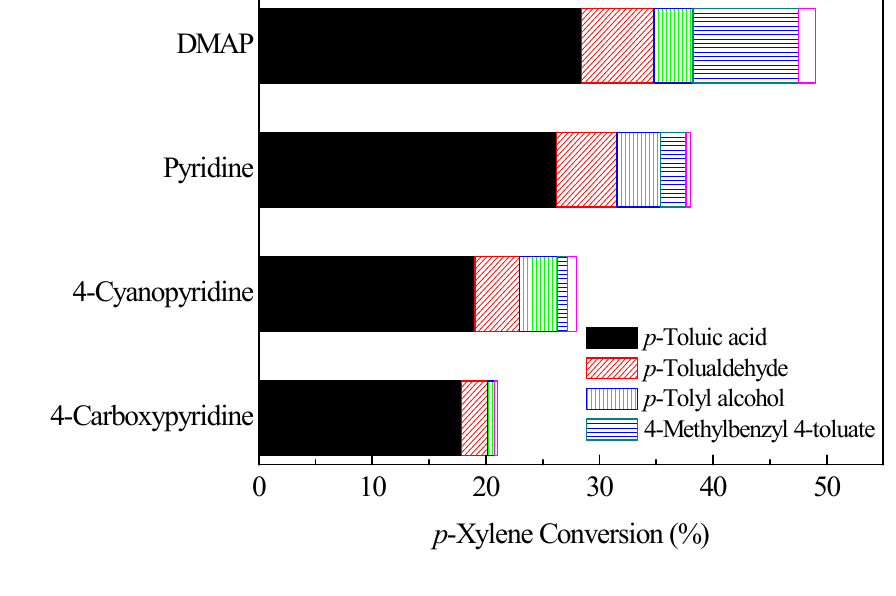
Figure 2. p -Xylene oxidation with different pyridine analogues; reaction conditions: p -Xylene (100 mmol), benzyl bromide (2.5 mmol), pyridine analogues (2.5 mmol), 1.0 MPa O , 160 °C, 3 2